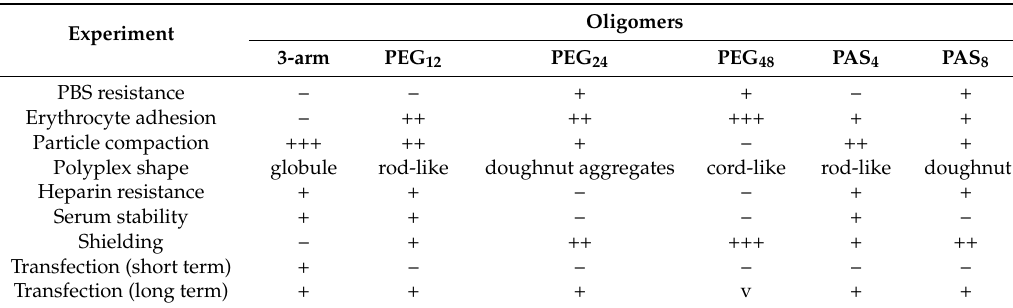
Table 3. Summary of oligomer characteristics.